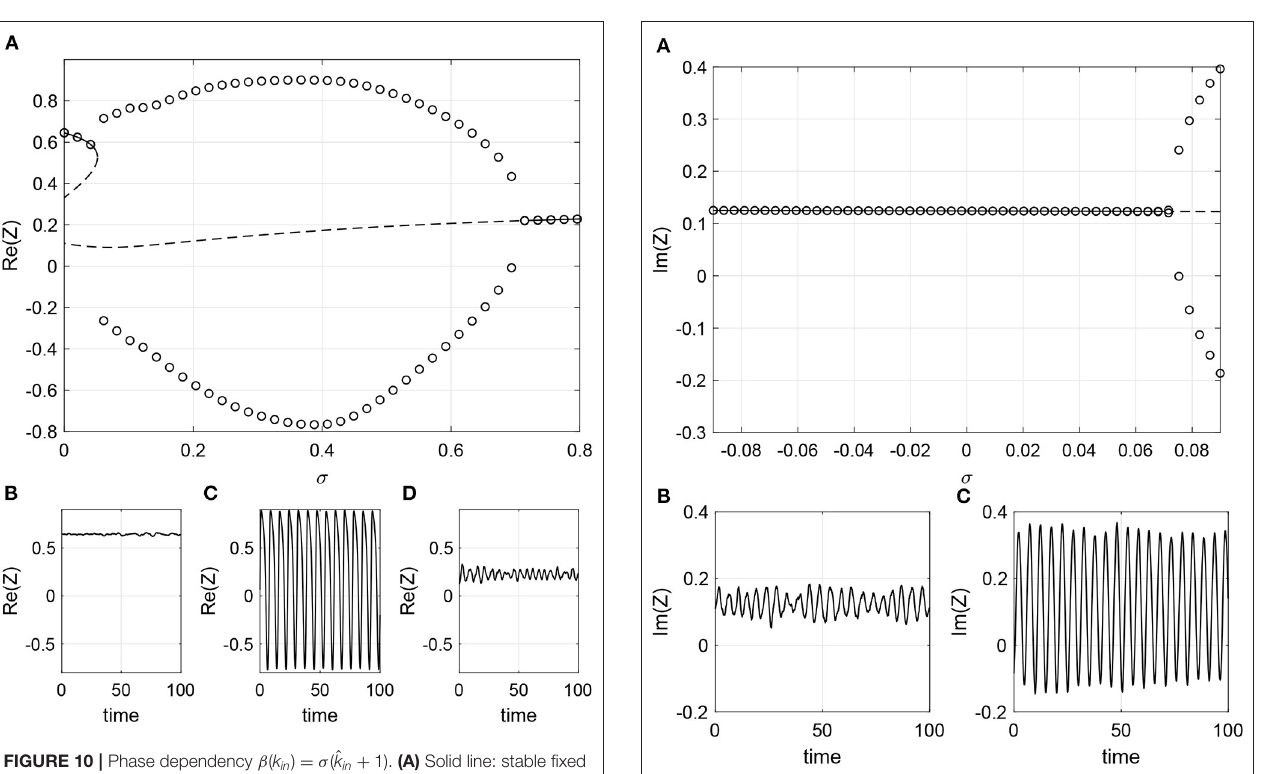
FIGURE 11 | Heterogeneity dependency 1 0, = stable fixed point of (40); dashed line: unstable fixed point. Circles: maximum and minimum over one period of Im( Z ). Im( Z ) calculated using (30) for (B) σ 0 and (C) σ 0.09. Other parameters: = =